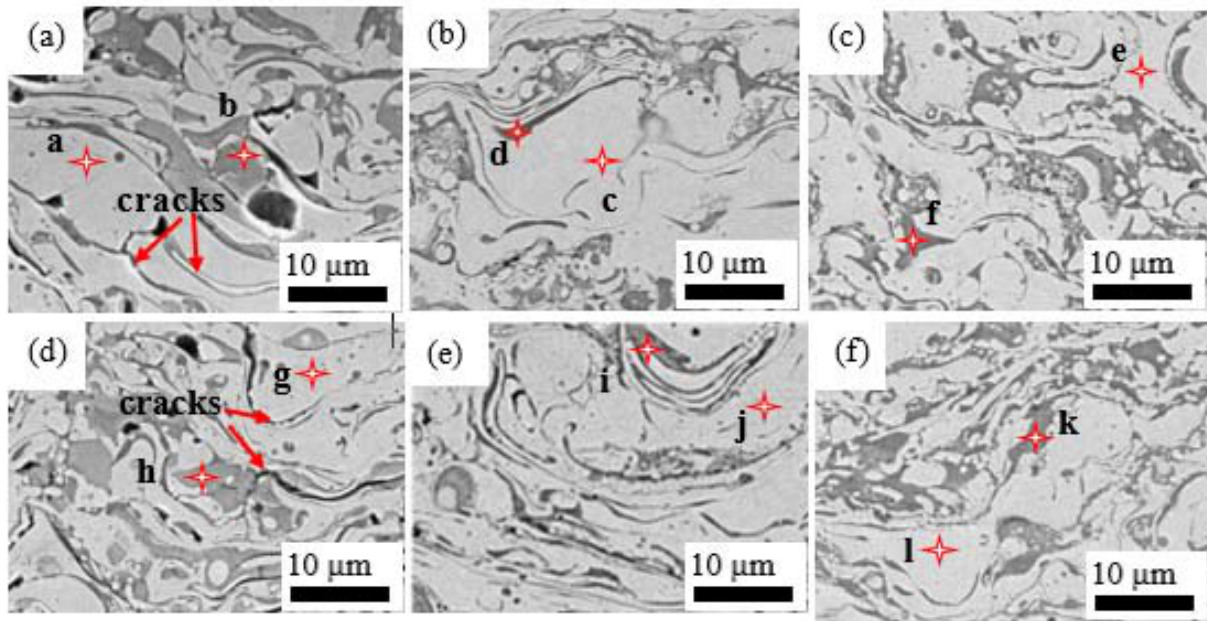
Figure 7. Cross ‐ sectional images for different plasma ‐ power heat ‐ treated at different temperatures; Figure 7. Cross-sectional images for different plasma-power heat-treated at different temperatures; Table 3. EDS results of the annealed coatings at different temperatures as marked area in Figure 5. Composition (at%) Coatings